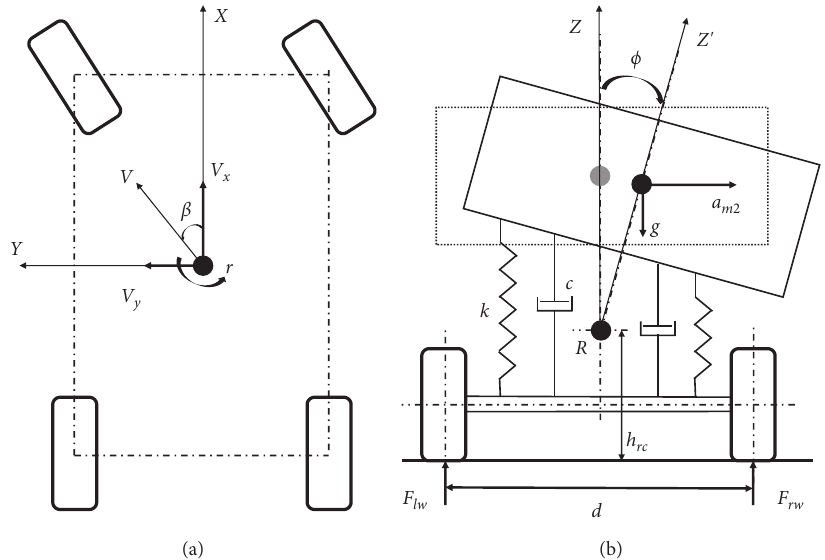
Figure 1: Modeling for vehicle lateral dynamics. (a) Model of two degrees of freedom. (b) Model of three degrees of